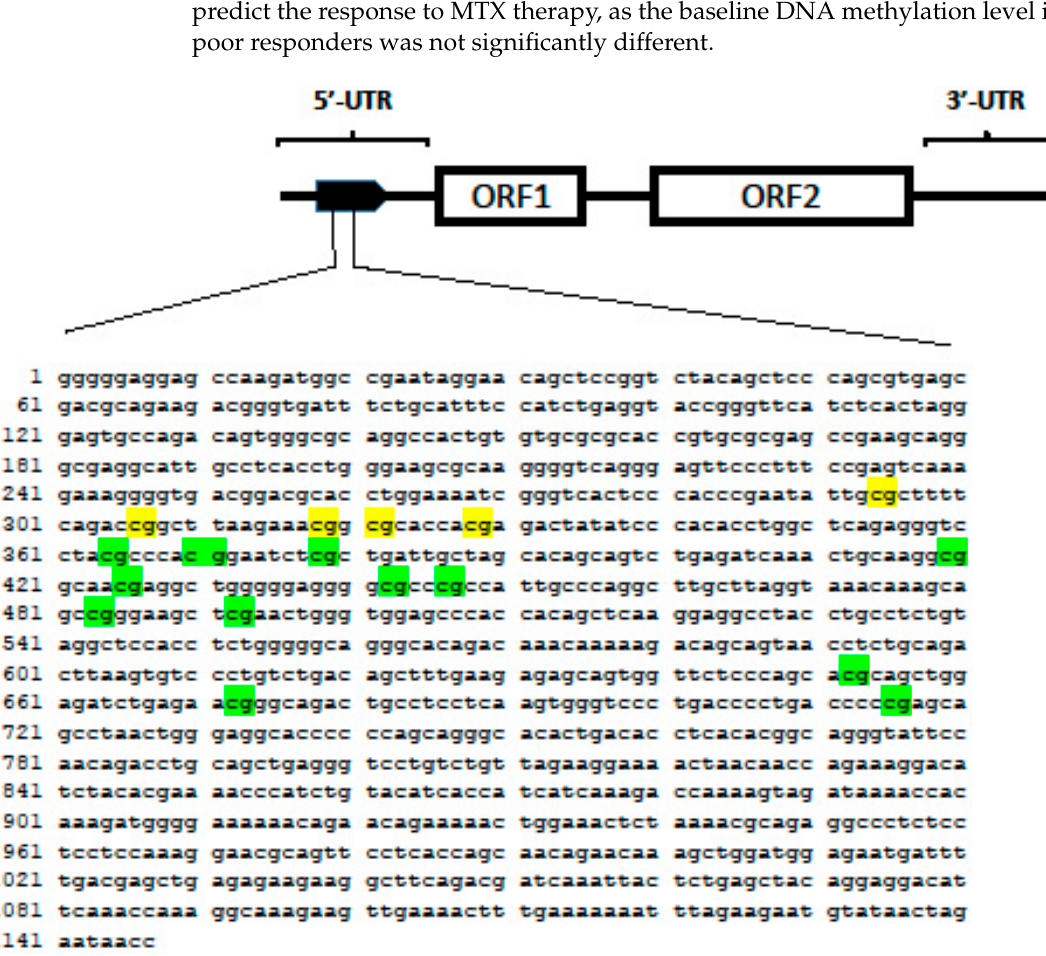
Figure 5. CpG island region of the human LINE-1 transposon (Locus X58075). The five CpG sites highlighted in yellow were investigated in the present study. The twelve CpG sites shown in green were studied by Gosselt et al. [31].